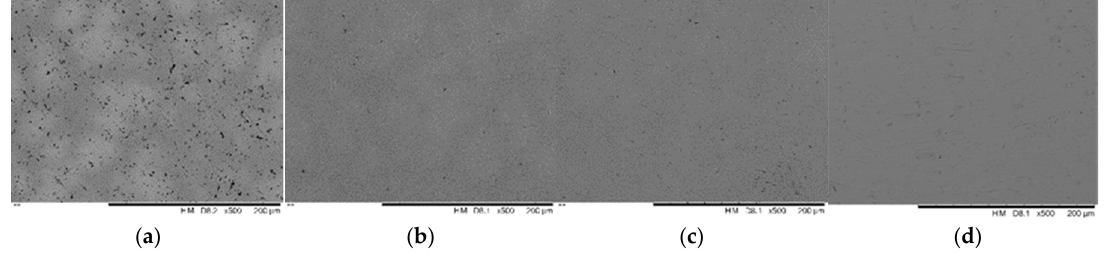
Figure 6. SEM micrographs (×500, 200 μ m) of the bare and coated TNZT alloy: TNZT ( a ), HA/TNZT ( b ), SiC-HA/TNZT ( c ), Ag-SiC-HA/TNZT ( d ).